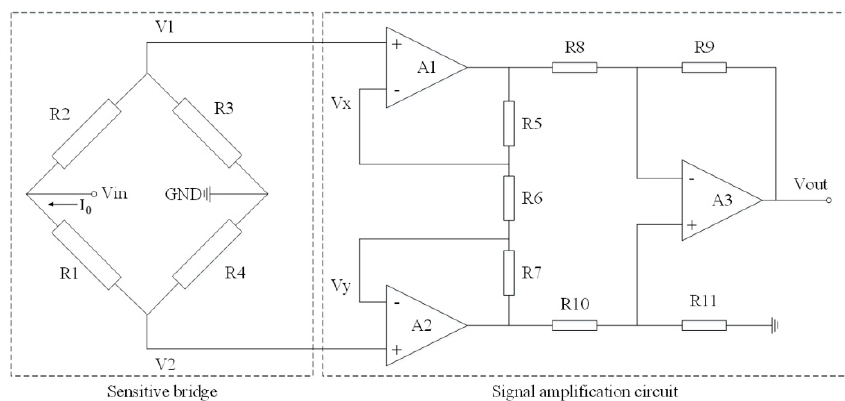
Figure 5. Wheatstone bridge and amplifier circuit.